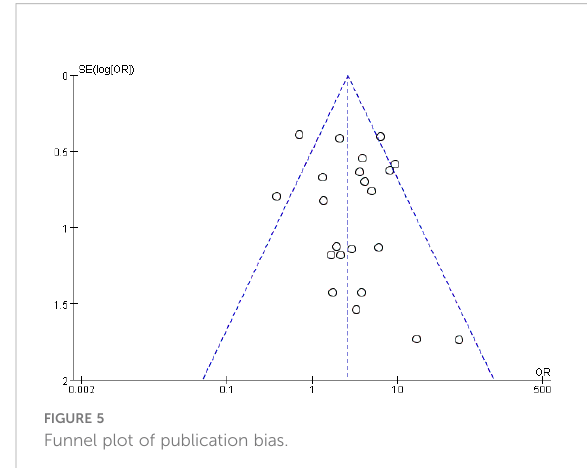
FIGURE 5 Funnel plot of publication